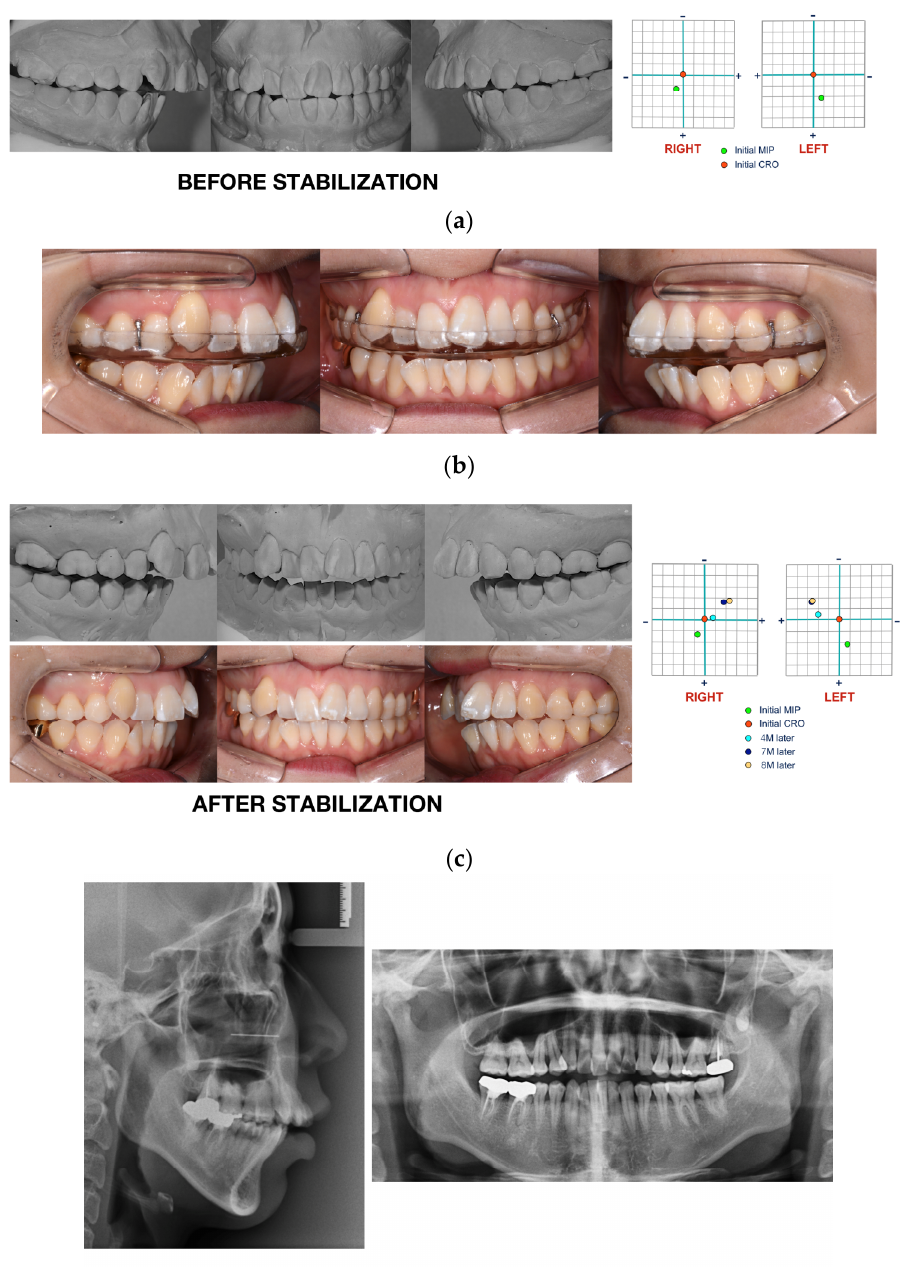
Figure 2. ( a ) Pretreatment dental models mounted in CRO and the MPI data. The MPI data presented MIP–CRO discrepancies at the joint level; ( b ) intraoral photographs during splint treatment; ( c ) post-stabilization intraoral photographs, dental models mounted in CRO, and changes of MPI data during the application of the stabilization splint. The MPI data discovered upward seating of the condyles in the articular fossae compared to their initial positions; ( d ) post-stabilization lateral cephalogram and panoramic